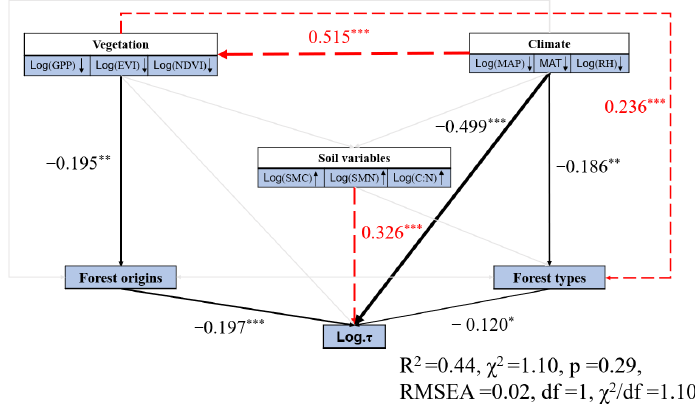
Figure A6. The main influencing factors of C turnover on the subsoil of the temperate zone were obtained by the SEM model. The symbols “ ↑ ” and “ ↓ ” indicate a positive or negative correlation between environmental factors and subsoil τ . The goodness of fit statistics for the effect size model of the relationship are as follows: ** p < 0.01, *** p < 0.001.